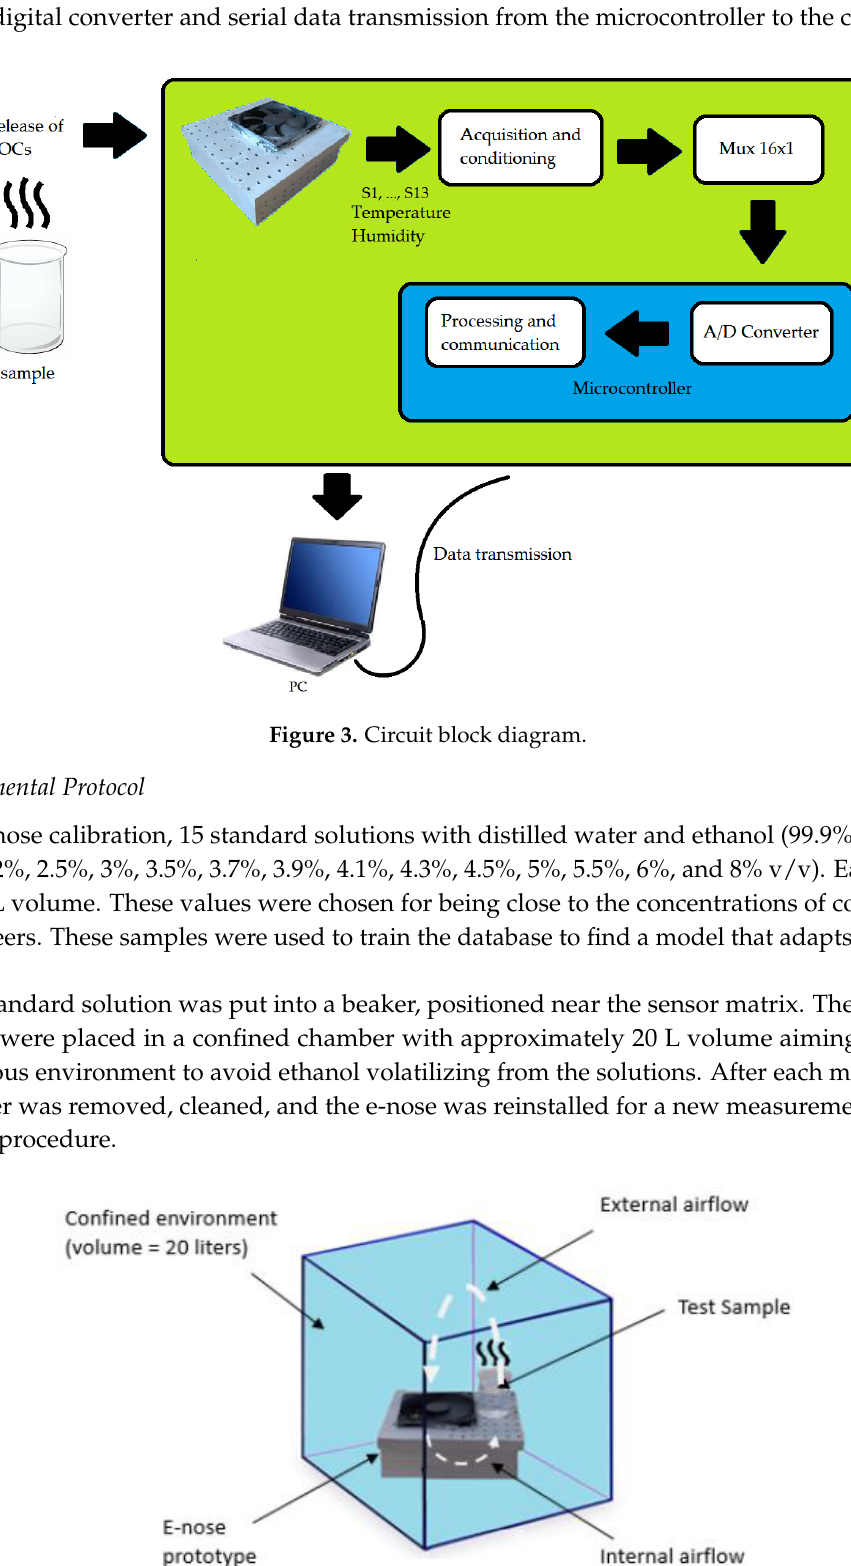
Figure 4. Standard solution sampling step.